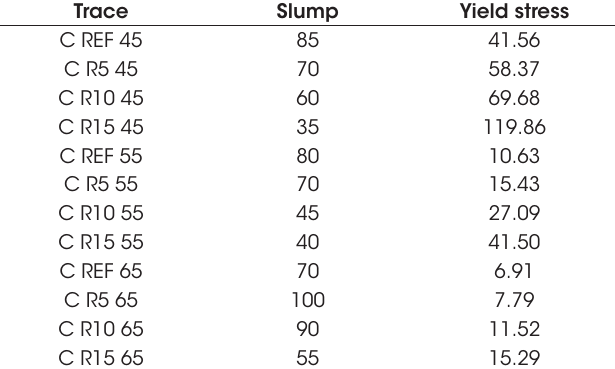
Slump test results obtained by Soares [35] related to the yield stress of the flow